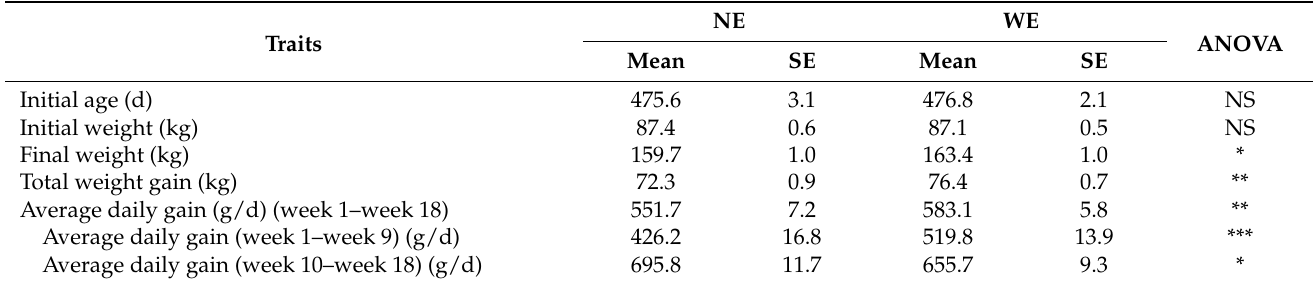
Table 6. Growth data and carcass, organ and cuts characteristics from Alentejano pigs kept on individual pens without exercise area (NE, n = 9) or outdoors with exercise area (WE, n = 9) from ~87 to 160 kg BW. Traits